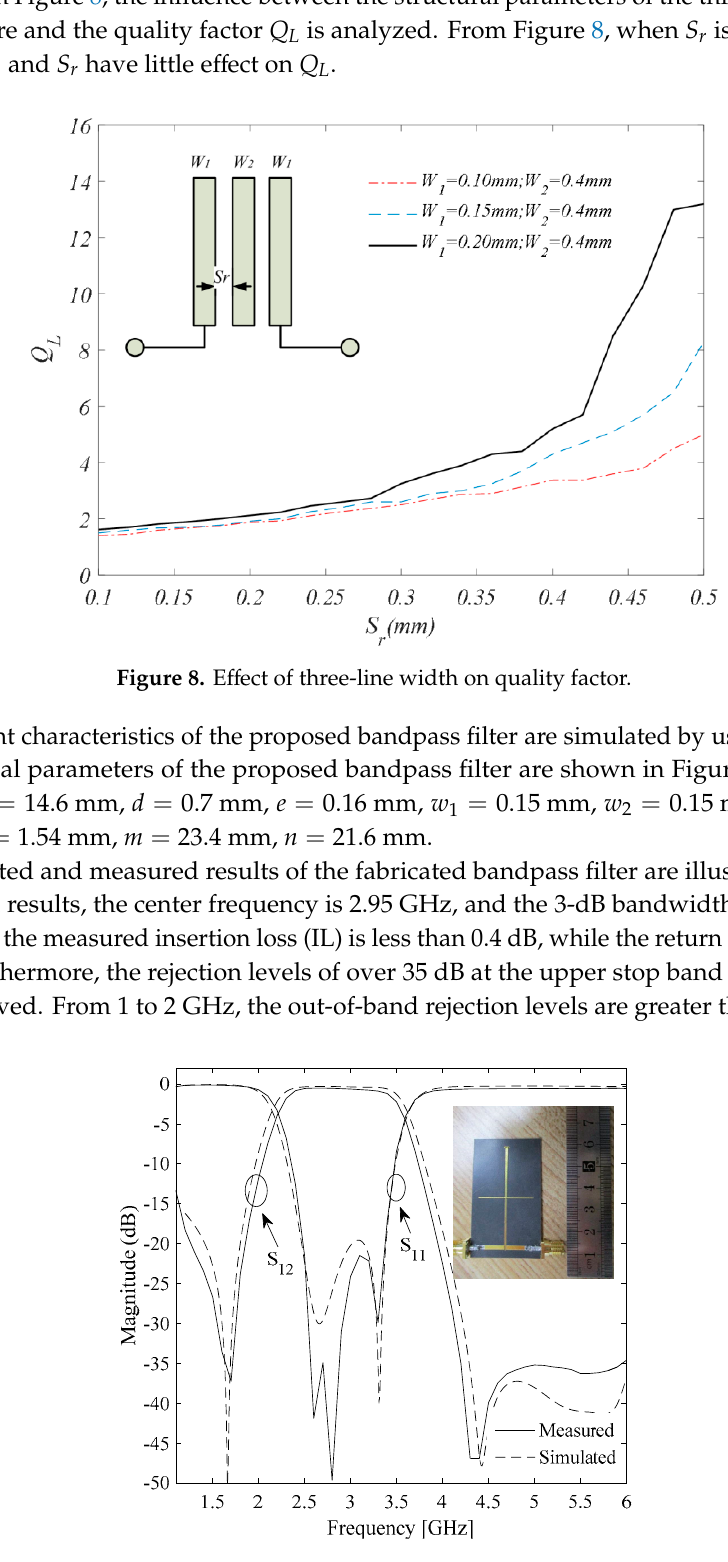
Figure 9. Simulated and measured results of the fabricated bandpass filter.